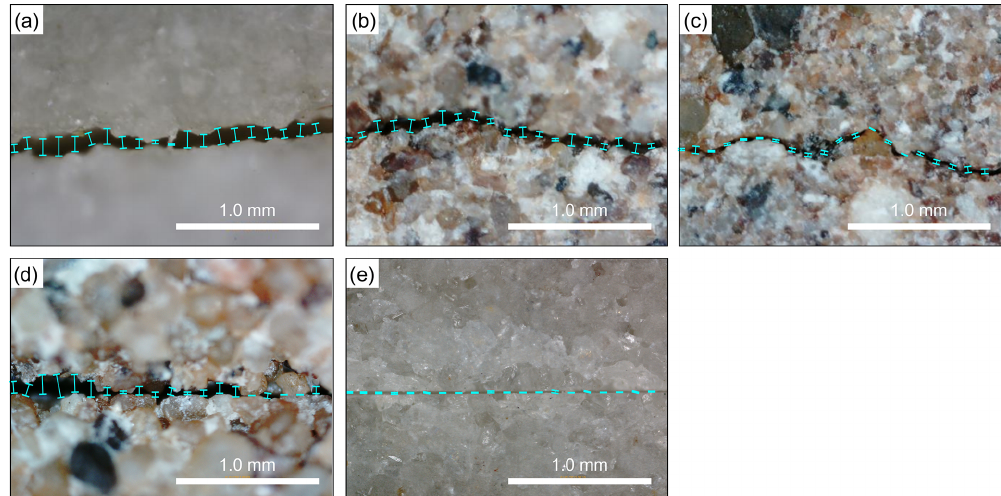
Figure 6. Representative microscopic images of the samples comprising parts of the respective fracture profiles. (a) FOF1, with a pre-offset of 0.75mm; (b) FF2, with a pre-offset of 0.2mm; (c) FF3, matched rough fracture; (d) FF4, saw-cut rough fracture; (e) FOF4, saw-cut smooth fracture. The distances between the upper and lower fracture walls were measured at equidistant locations.